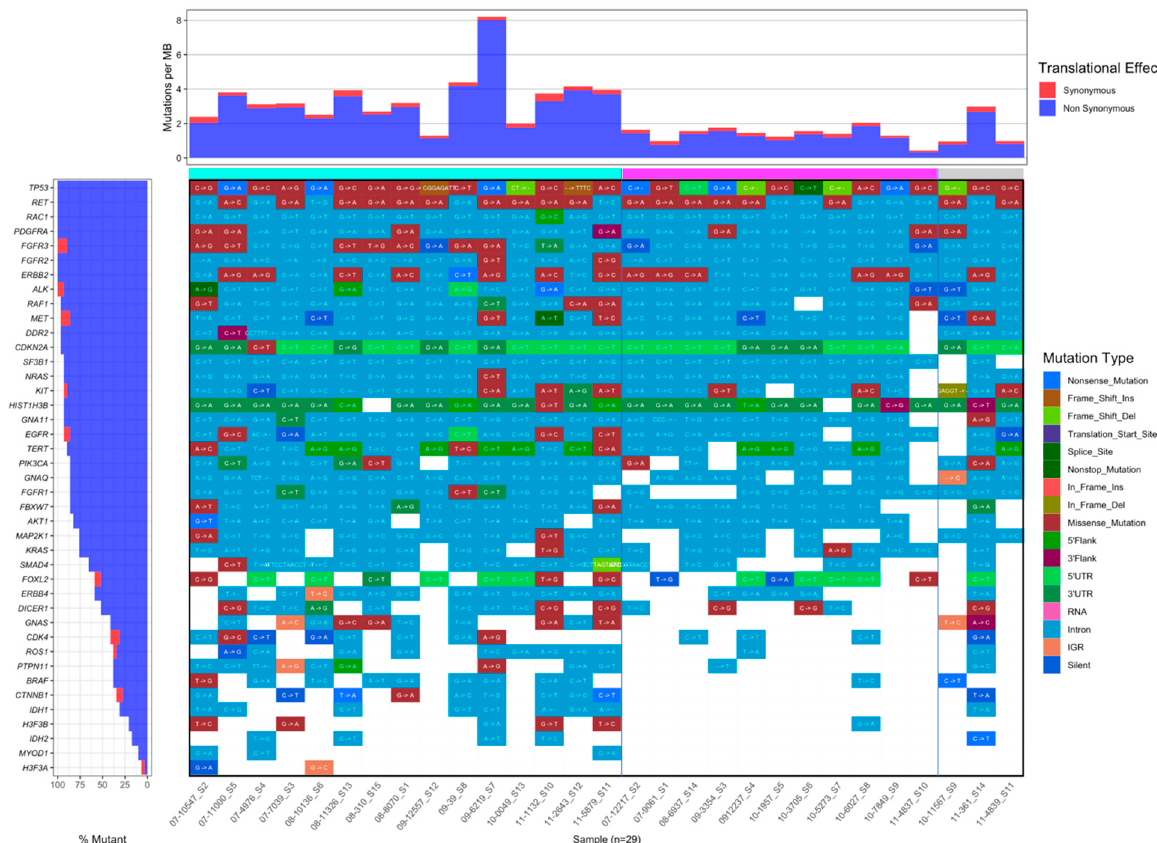
Figure 5. Comparison of pathogenic mutation by type and frequency in IM subtype (magenta) and non-IM subtypes (teal) according to the Lehmann classification for TNBC patients. The last three samples (light gray) are unclassified samples, which were sequenced for comparison reasons. The top bar shows the mutation rate by translational effect per sample, and the left bar plot shows the mutation rate and its translational effect by gene; synonymous variants are marked in red and non-synonymous in blue. The top mutated gene is TP53 , followed by RET , RAC1 , and PDGFRA